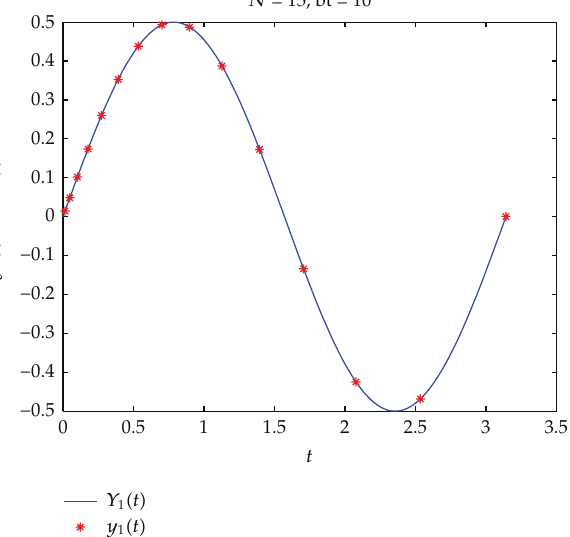
Figure 3: Numerical solution and exact